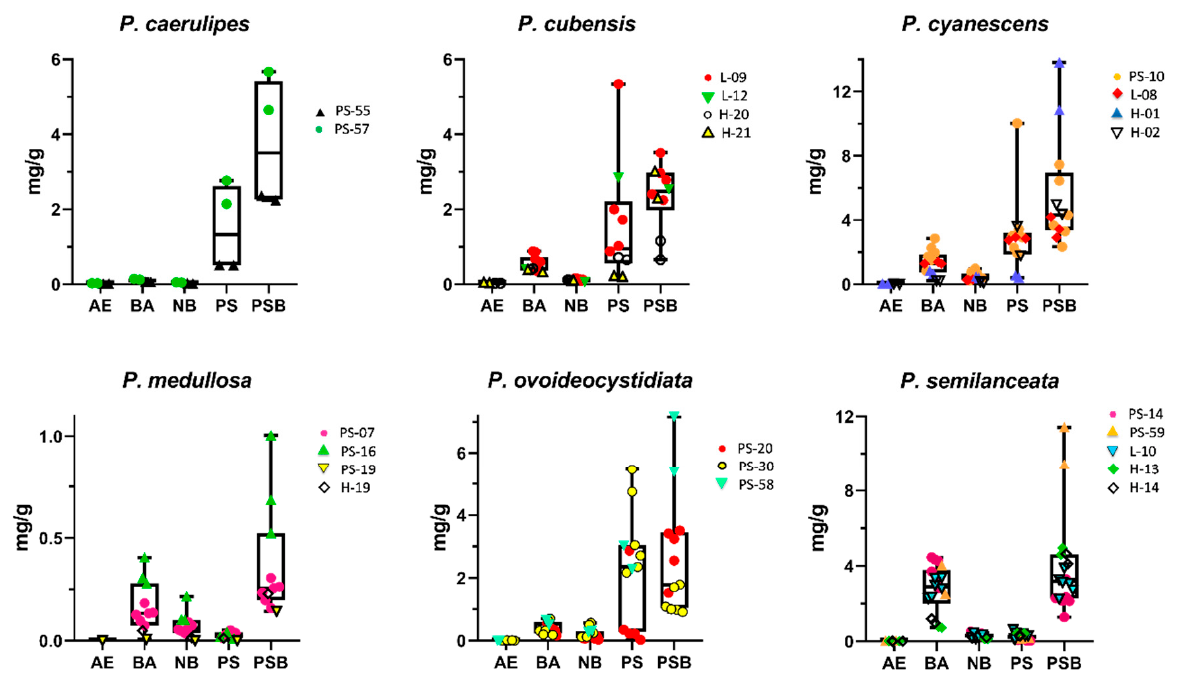
Figure 4. Tryptamine concentrations (mg/g in dry mass) in six Psilocybe species presented in boxplots for a minimum of two individual collections. The line in the boxplot represents the median and the whiskers signalize the minimum and maximum of the measured values.